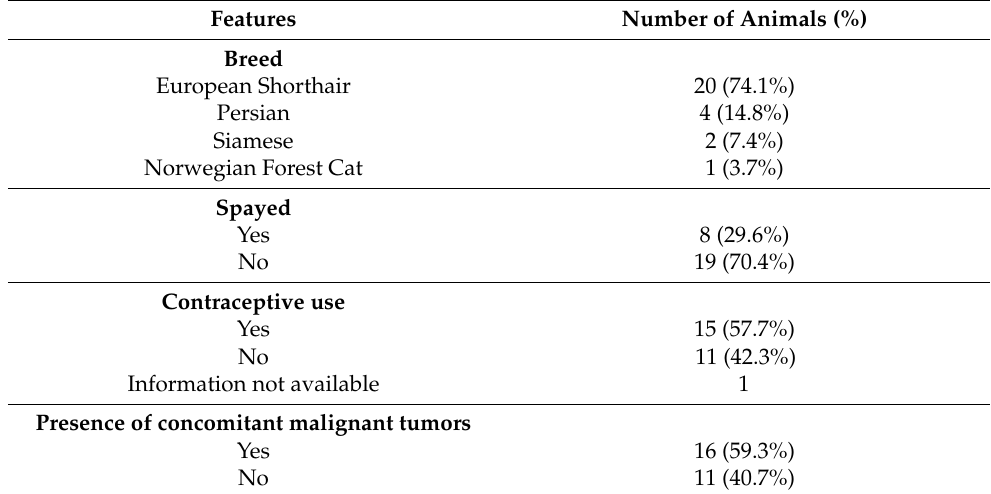
Table 3. Clinicopathologic findings of the 27 cats enrolled in the study.